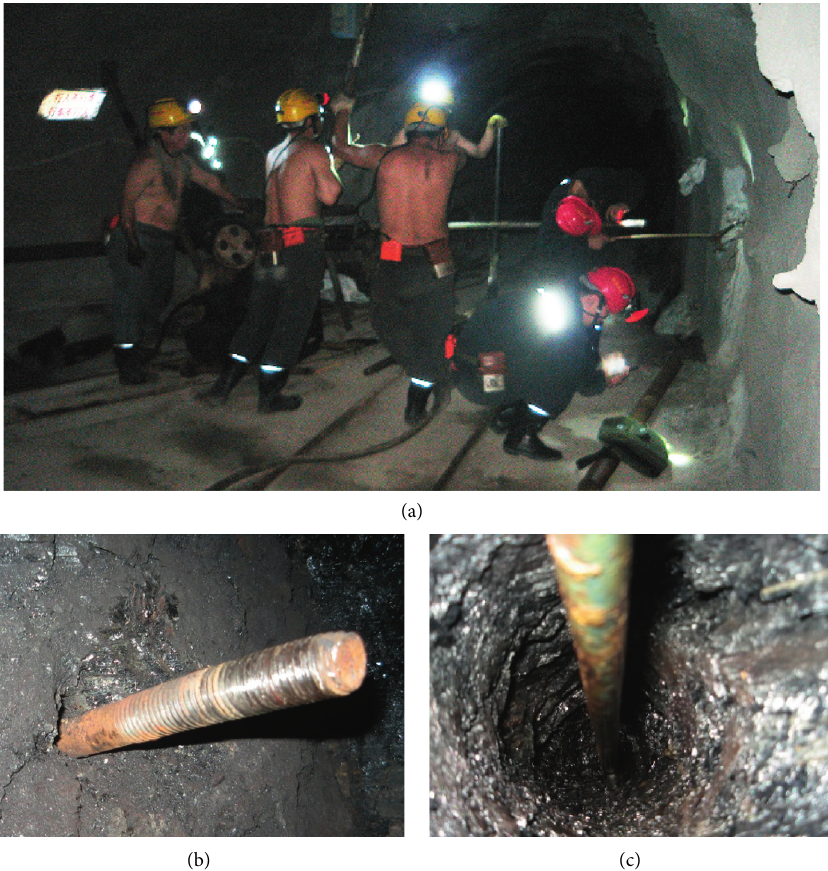
Figure 1: Field sampling diagram. (a) On-site drilling for bolt samples. (b) The bolt before drilling. (c) The bolt after drilling.